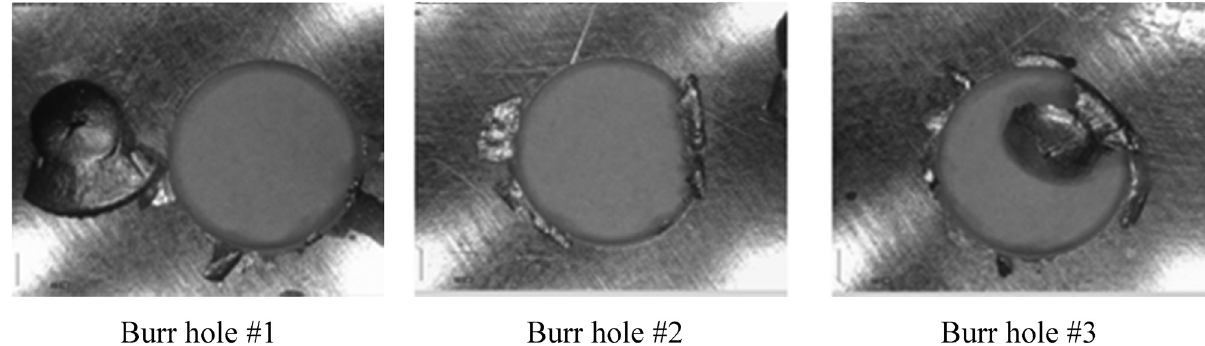
Figure 6: Burr holes after drilling with optimized